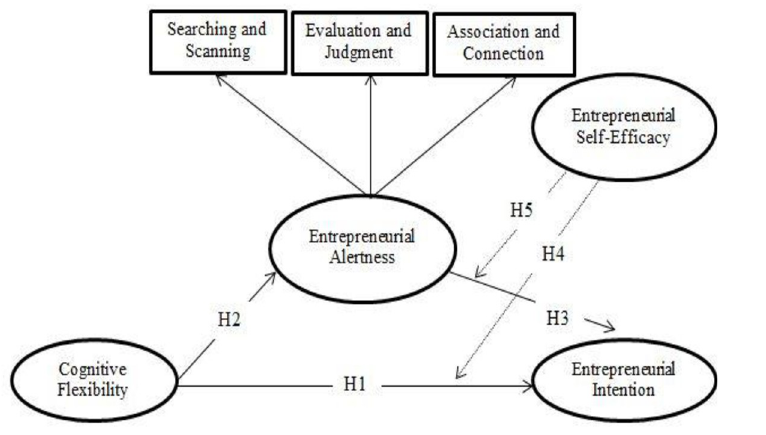
Fig 1. Conceptual